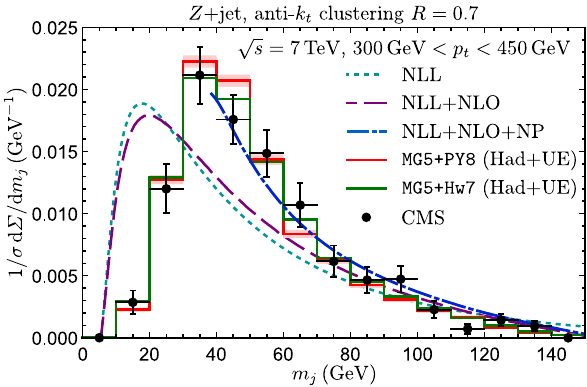
Fig. 14 Resummed differential m j distribution with anti- k t clustering and R = 0 . 7 in Z ( → (cid:9) + (cid:9) − ) + jet events, with (cid:9) = e ,μ , compared to experimental data from CMS [19] and MadGraph+Pythia 8 and Herwig 7 results. The experimental data are taken from Ref.